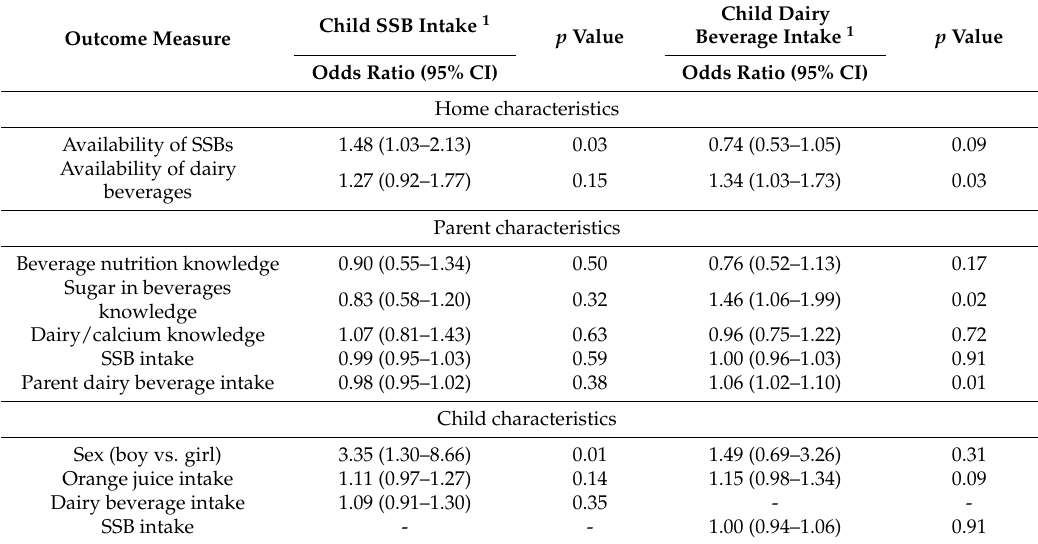
Table 4. Associations between child SSB and dairy beverage intakes and parent and home-related factors based on multiple logistic regression